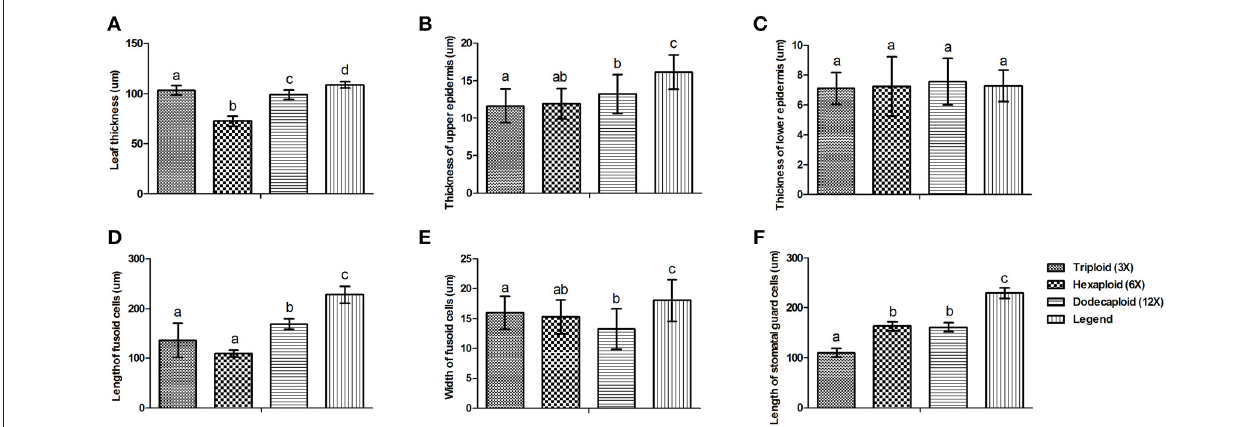
FIGURE 2 | Differences in anatomical features of Dendrocalamus latiflorus plants of different ploidy levels. (A) Leaf thickness, (B) Thickness of upper epidermis, (C) Thickness of lower epidermis, (D) Length of fusoid cells, (E) Width of fusoid cells, (F) Length of somatal guard cells. Different capital letters indicate a significant difference between ploidy levels at p < 0.05 (Duncan,